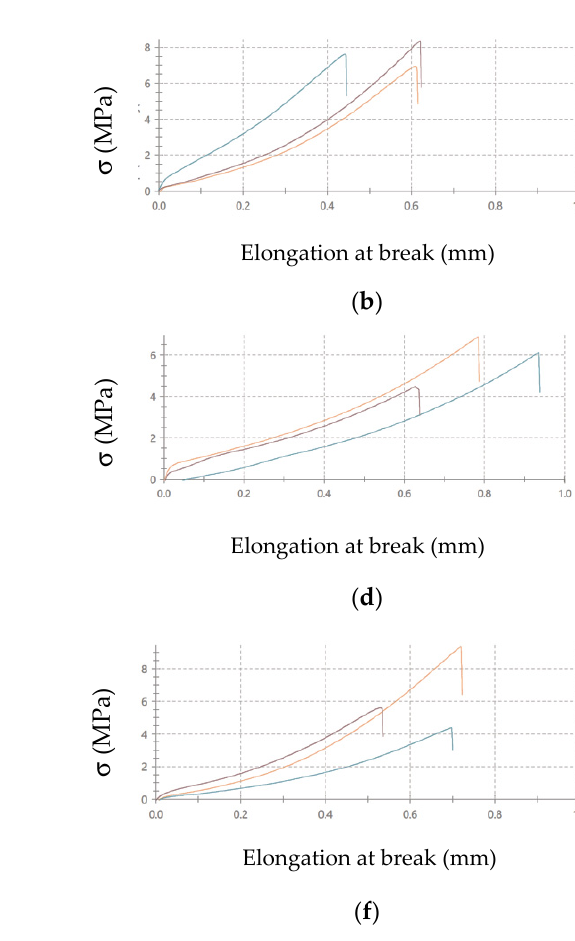
Figure 7. Stress-elongation at break curves of simple varnish (X) coated steel adhesive joints: ( a ) C-1.4404-XB, ( b ) E-1.4404-XB, ( c ) C-DX51DZ-XB, ( d ) E-DX51DZ-XB, ( e ) C-50CRV4-XB, ( f ) E-50CRV4-XB (designation according to Table 7).